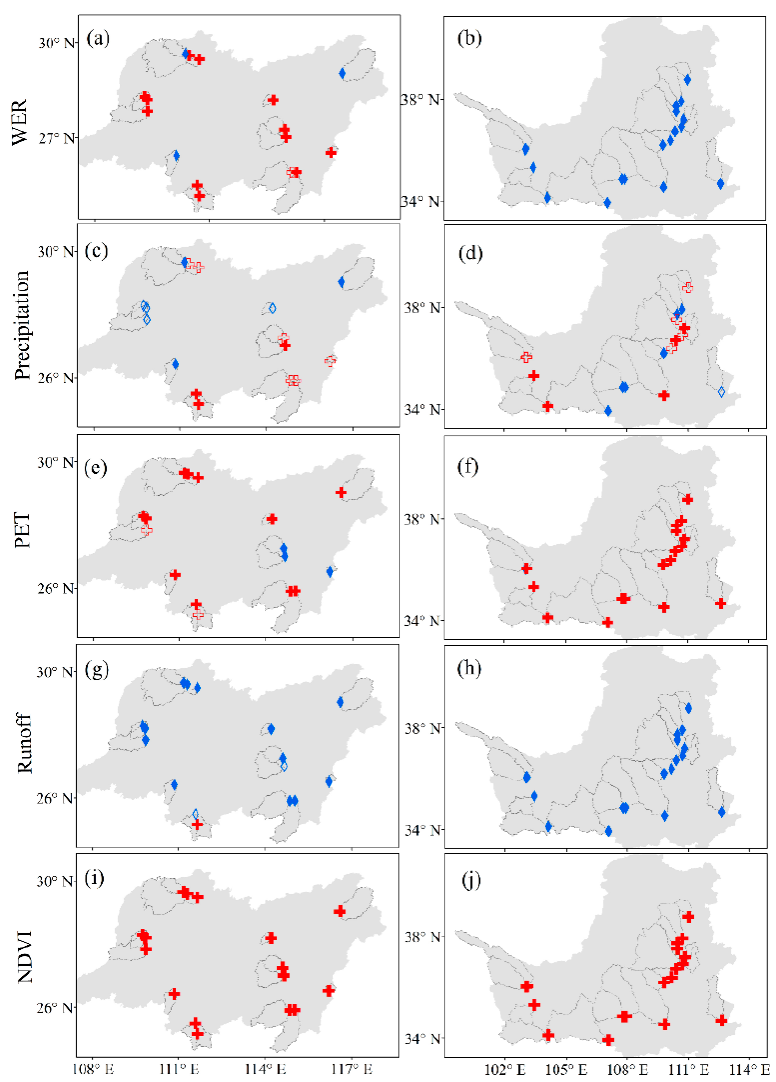
Figure 3. Changes in WER, climate variables and NDVI in the 34 selected catchments. Red indicates increase trends, and blue indicates decrease trends. Solid indicates that the trend is significant ( p < 0.01), and hollow indicates that the trend is insignificant ( p > 0.01). The left column, from ( a – i ), represents the energy-limited condition, and the right column, from ( b – j ), represents the water-limited condition. WER: available-water-to-available-energy ratio.